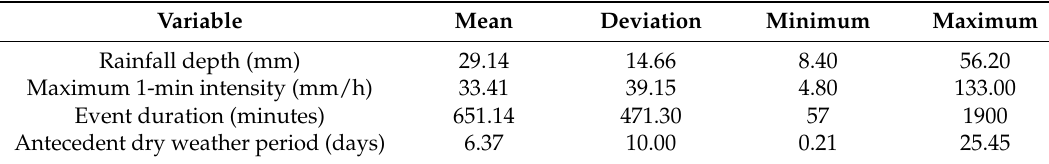
Table 2. Characteristics of rainfall events for water quality analysis.